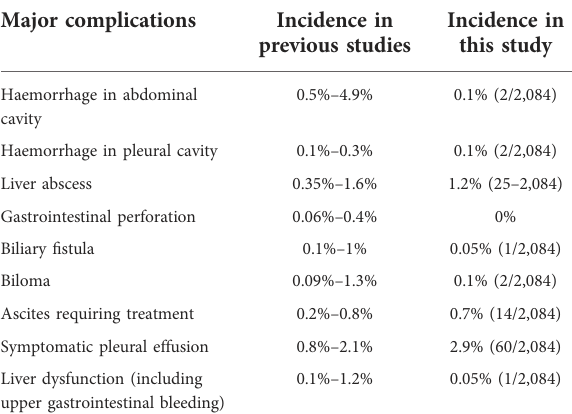
TABLE 4 Incidence of common major complications between previous studies and this study.